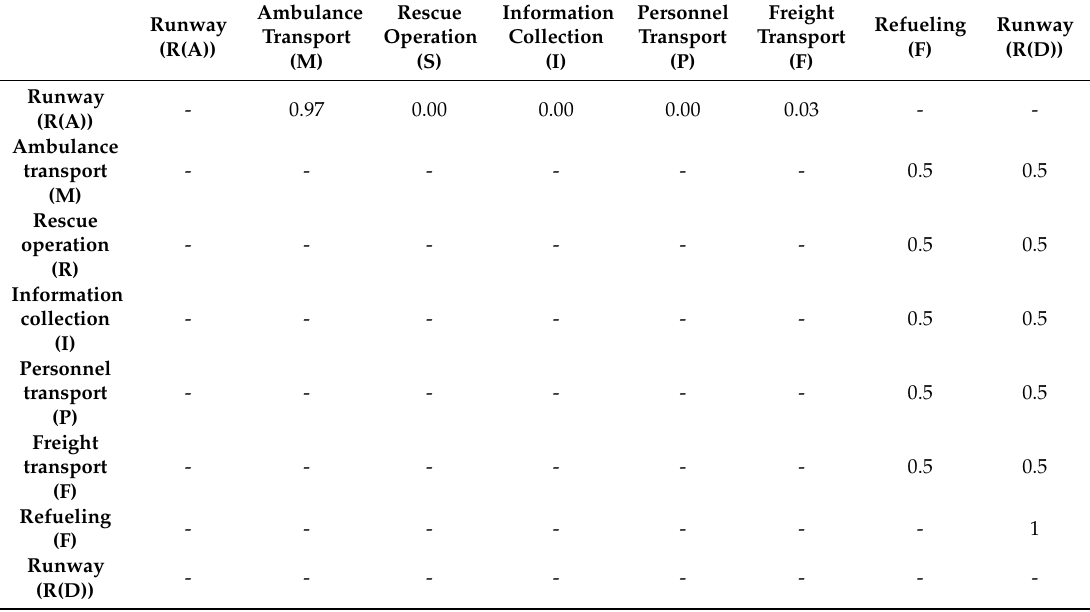
Table 5. Transition matrix for medical helicopter: Hanamaki Airport.